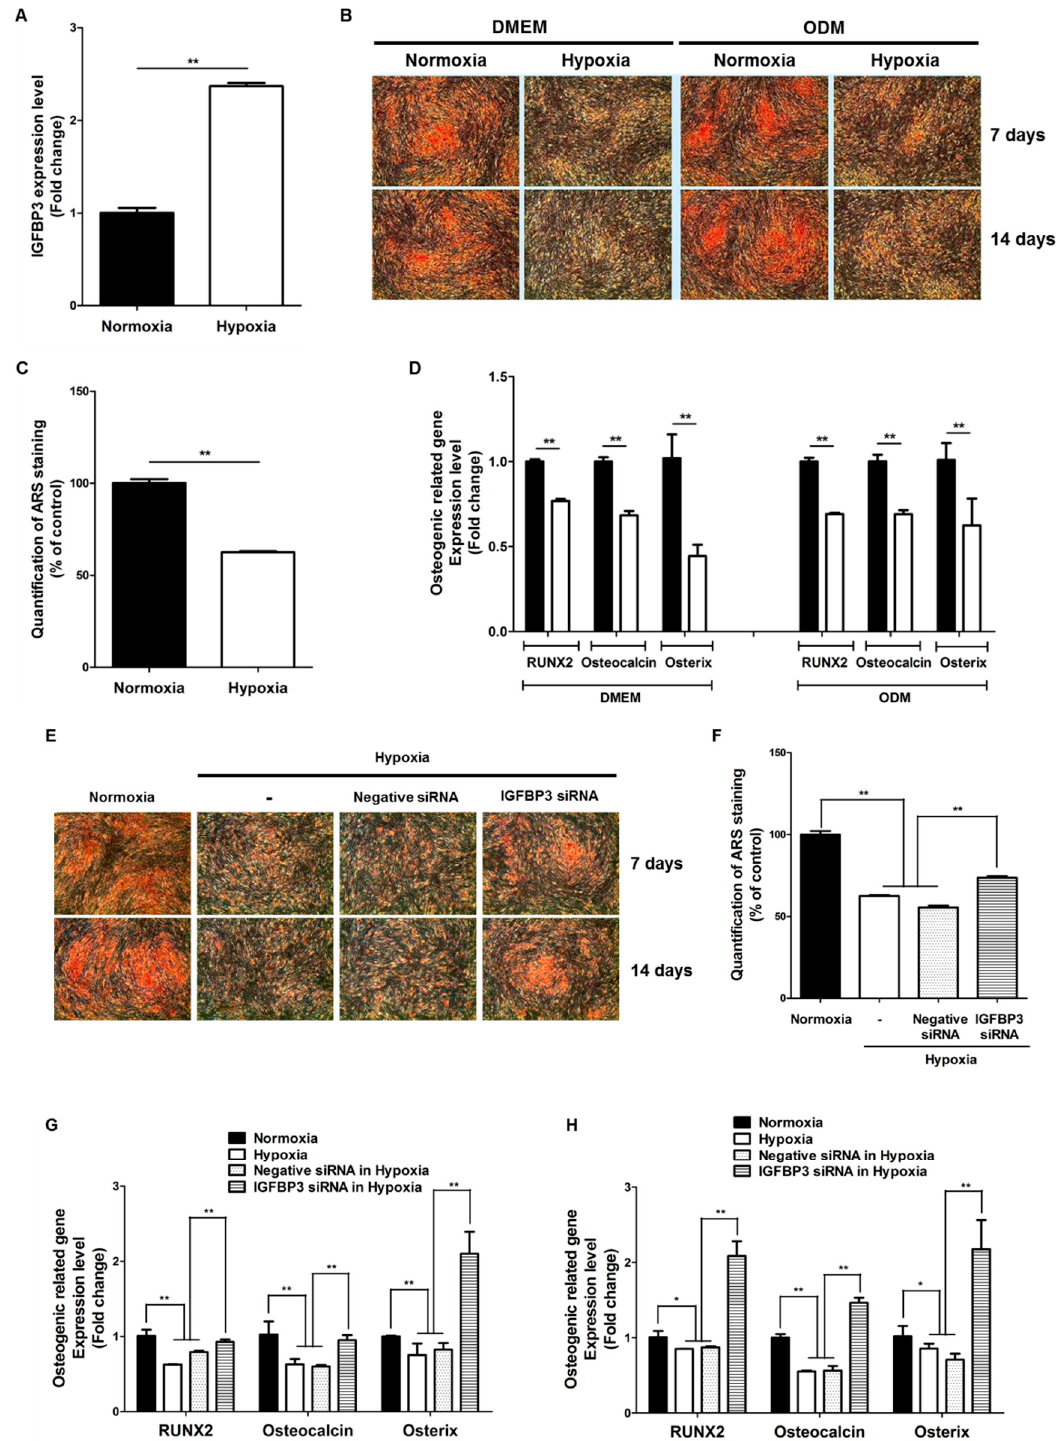
Figure 6. Hypoxia suppresses the osteogenic differentiation of clonal BM-MSCs. ( A ) Hypoxia (2%) induced the mRNA expression of IGFBP3 in clonal BM-MSCs; ( B ) hypoxia suppressed the osteogenic differentiation of clonal BM-MSCs at 7 and 14 days (40 × ); ( C ) quantification of ARS staining was measured at 7 days; ( D ) osteogenic induction markers such as RUNX2, osteocalcin, and osterixwere significantly reduced by hypoxia in DMEM and ODM; ( E ) siRNA-mediated inhibition of IGFBP3 significantly attenuated the hypoxia-suppressed osteogenic differentiation of clonal BM-MSCs at 7 and 14 days (40 × ); ( F ) quantification of ARS staining was measured at 7 days; ( G , H ) osteogenic induction markers such as RUNX2, osteocalcin, and osterix were significantly reduced by hypoxia at 7 days ( G ) and 14 days ( H ). Normoxia: black bars, hypoxia: white bars. * p < 0.5, ** p < 0.01.